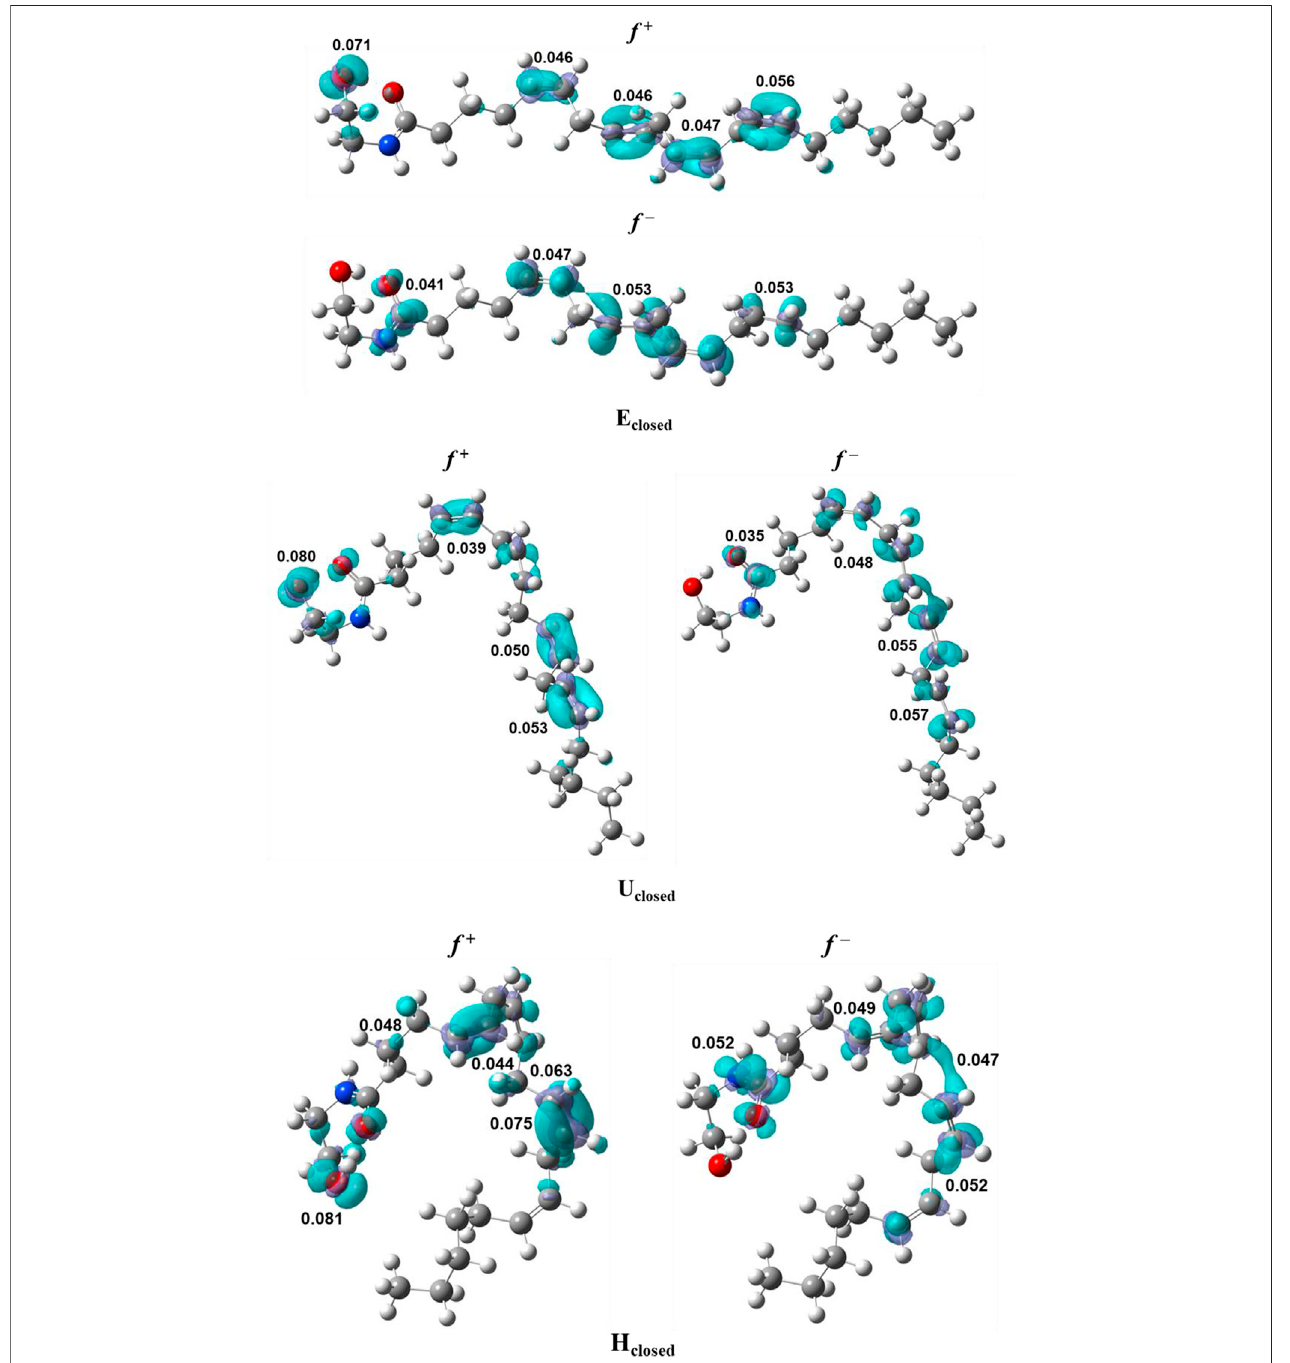
FIGURE 1 | Fukui functions, f + and f – , of the conformers of anandamide: E closed , U closed , and H closed , obtained at the BP86/cc-pVTZ level of theory in chloroform.